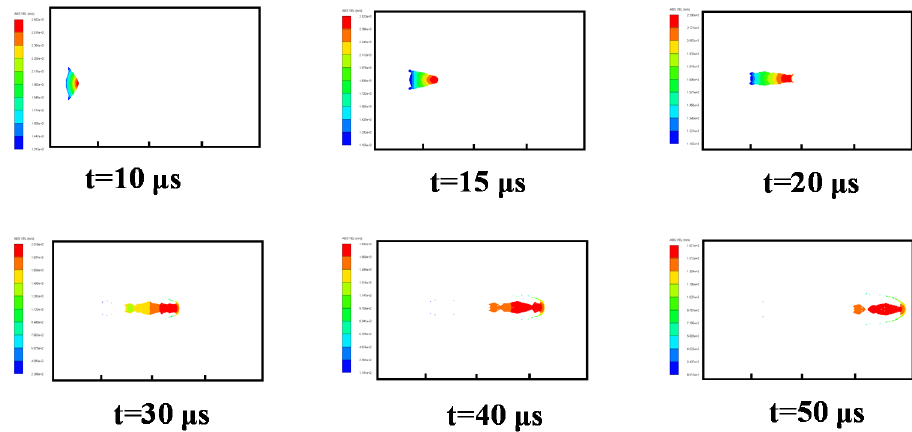
Figure 10. Velocity distribution of the EFP for Case 4.